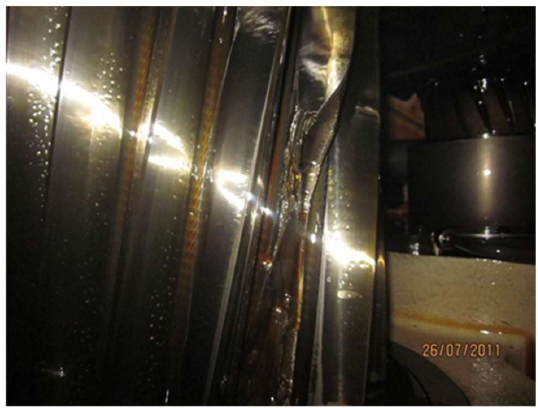
Figure 13. Photograph of gear 2 at intermediate shaft with a broken teeth found out during inspection.